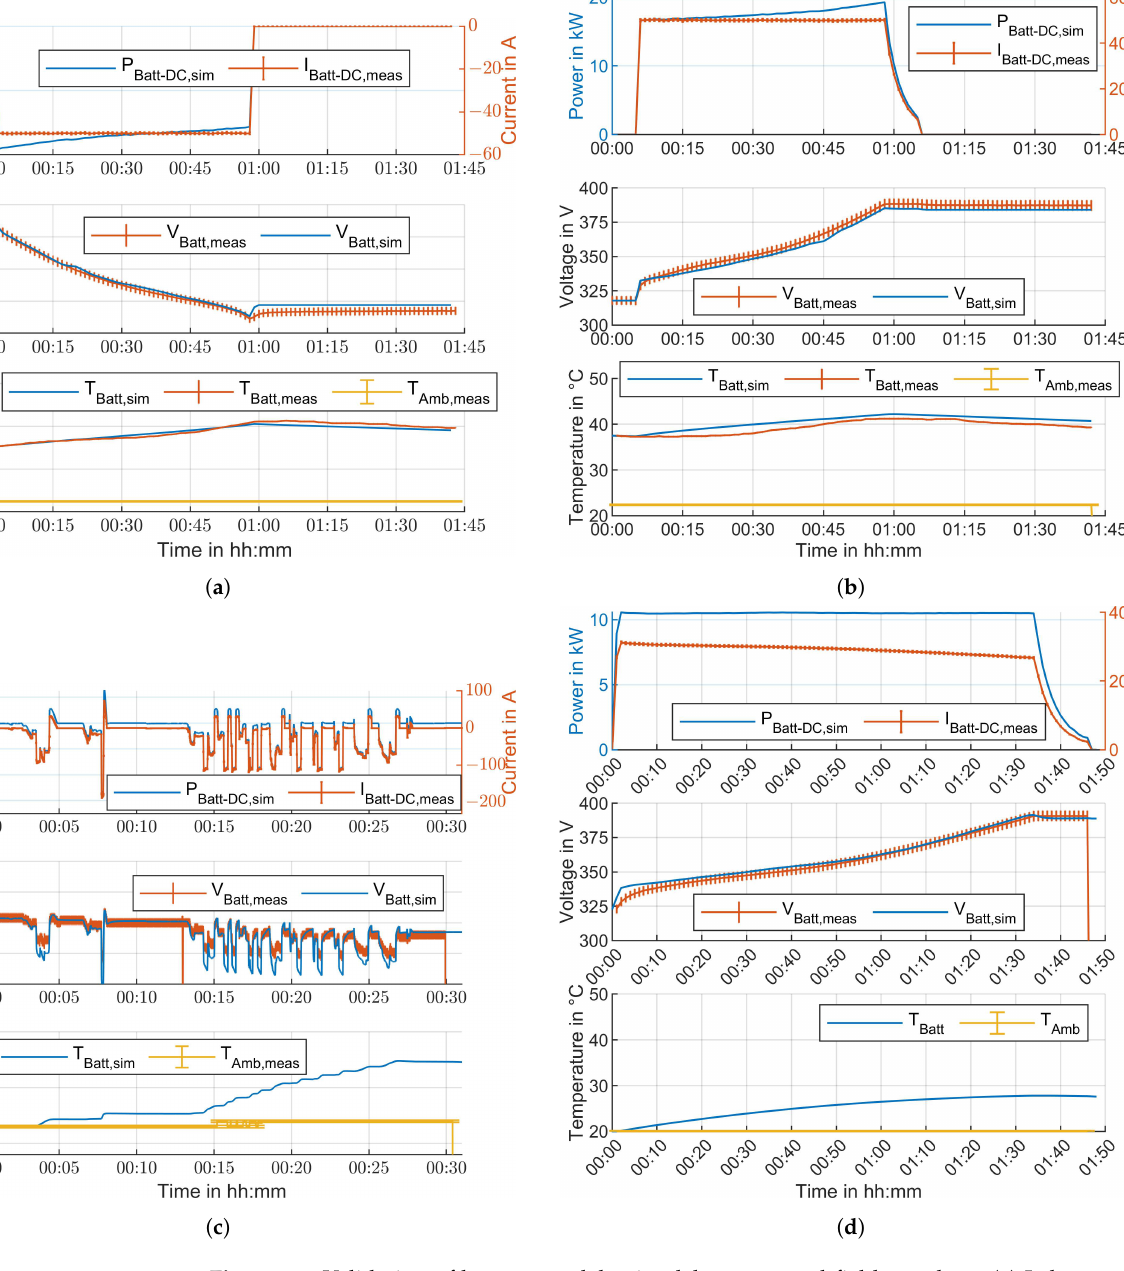
Figure 11. Validation of battery model using laboratory and field test data. ( a ) Laboratory pack test measurements and simulation: Full 1C Discharge; ( b ) Laboratory pack test measurements and simulation: Full 1C Charge; ( c ) Driving profile measurement and simulation with 1s resolution; ( d ) Measurement and simulation of 11kW